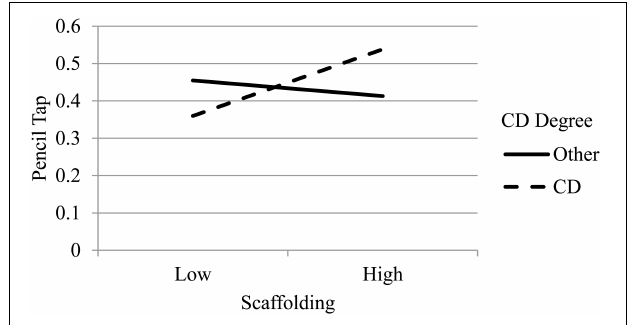
FIGURE 3 | Moderated effect of implementation quality (scaffolding) on children’s pencil tap scores by teacher educational background. CD, Child